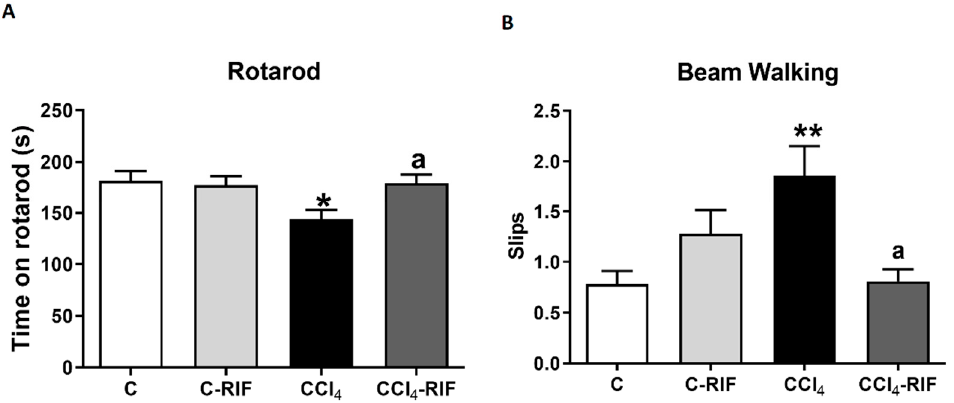
Figure 12. Mild liver damage induces motor in-coordination in rats which is prevented by rifaximin. Motor coordination was analyzed by ( A ) rotarod at 3 weeks and ( B ) beam walking at 4 weeks. Values are mean ± SEM of 10–14 rats per group. One-way ANOVA with Tukey’s test for rotarod (F(3,43) = 3.327, p < 0.05) and Welch’s ANOVA with Dunnett’s test for beam (W(3,26) = 4.851, p < 0.01) were performed to compare all groups. Values significantly different from control rats are indicated by asterisks and from CCl4 rats by a. * p < 0.05, ** p < 0.01, a p <